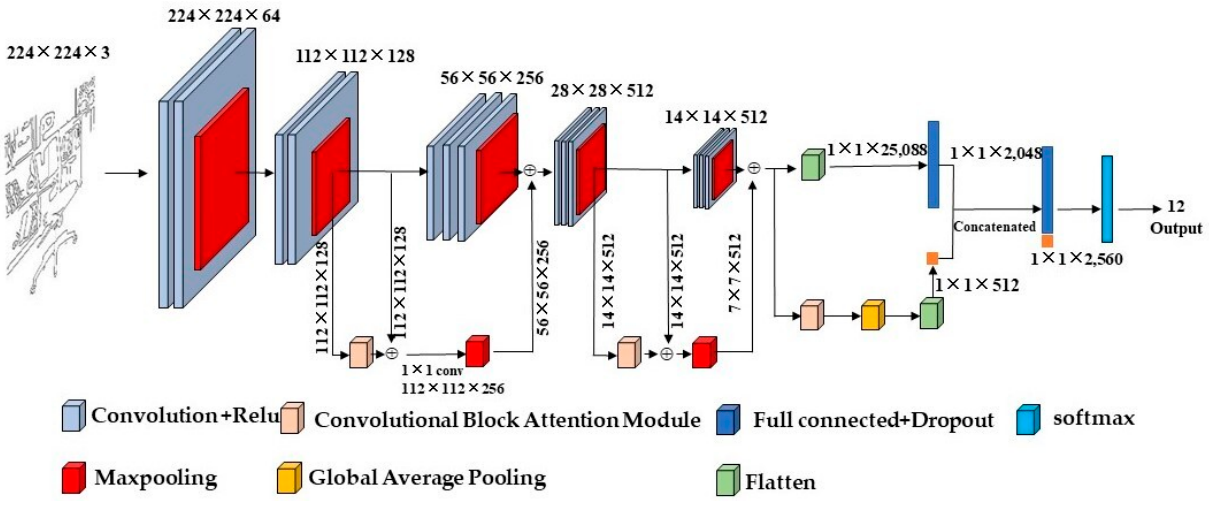
Figure 2. AM ‐ rVGG model framework. Figure 2. AM-rVGG model